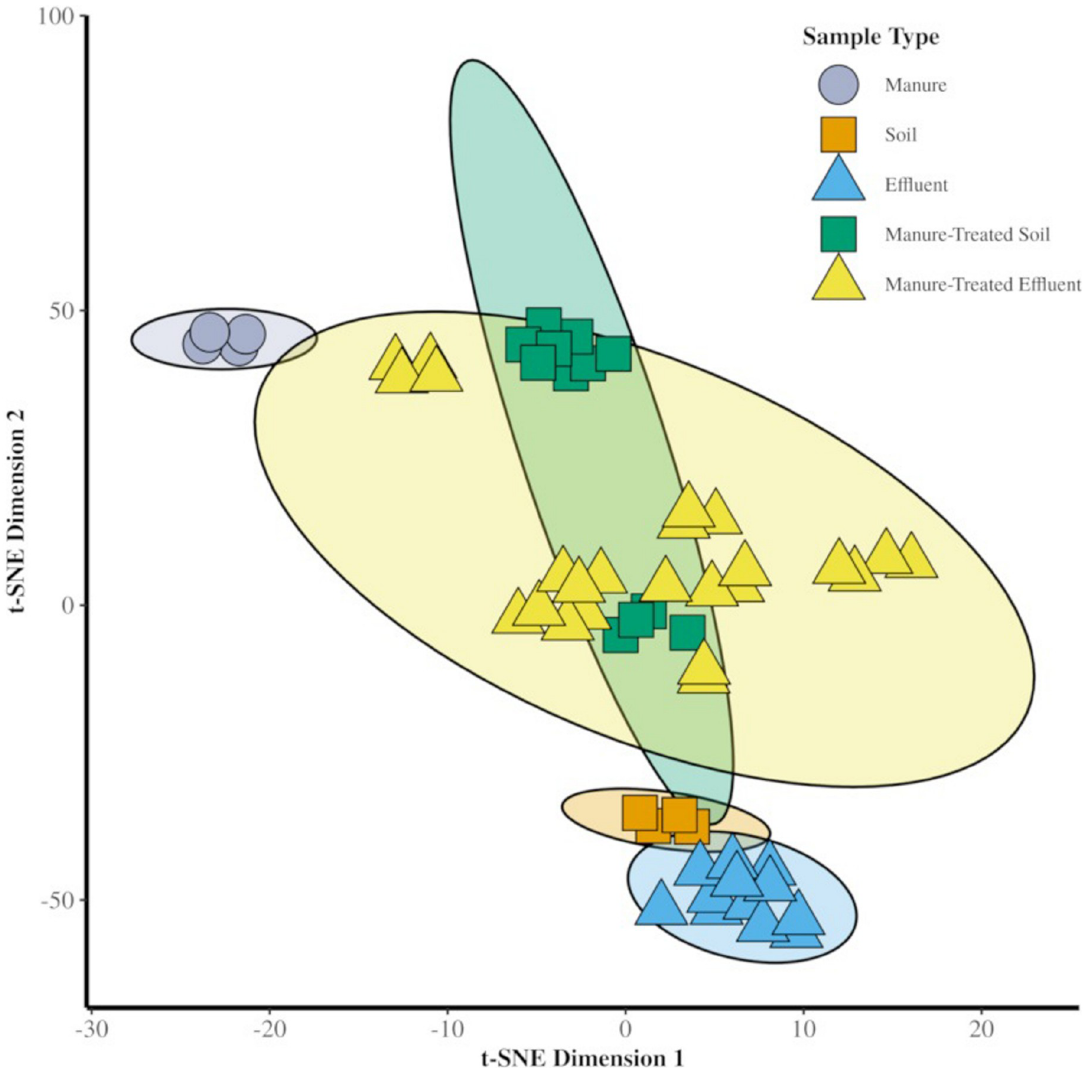
Fig 2. t-SNE dimension reduction using the Bray-Curtis distance of the 56 samples, based on read-sequence relative abundance. Different shapes represent different sample sources (e.g., both control soil and manure-treated soil samples are squares). The ellipse represents 95% confidence intervals of the variance for each sample